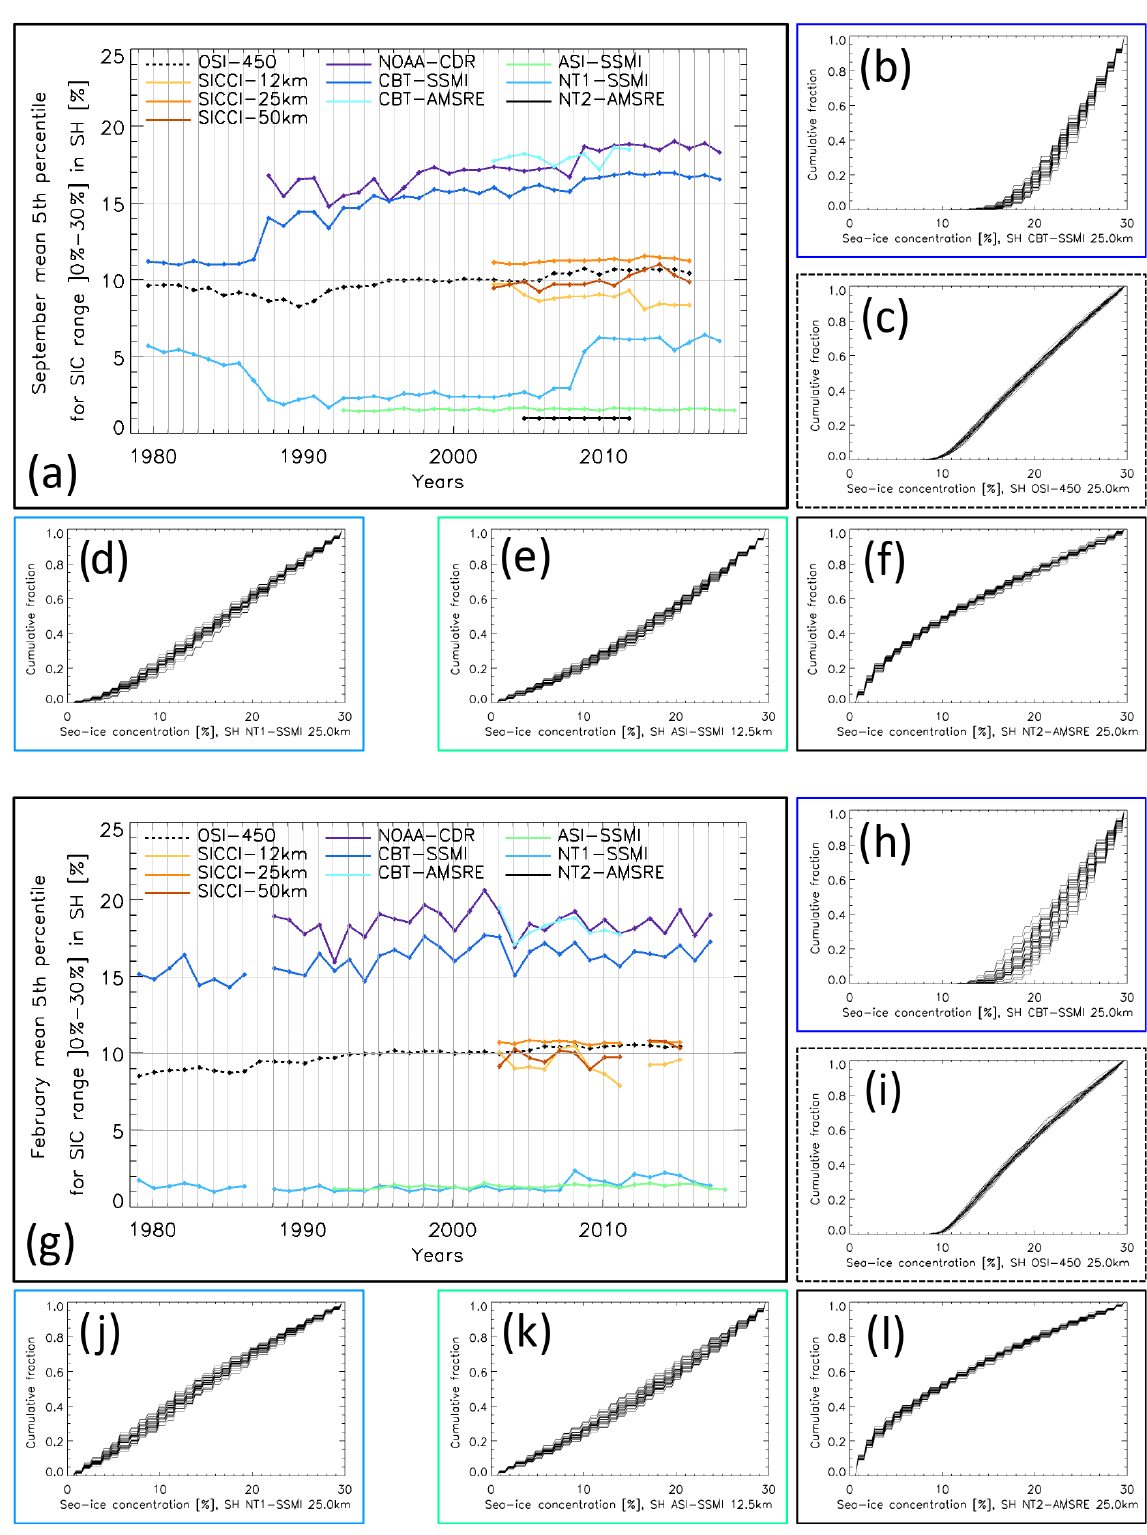
Figure 2. Time series of the monthly mean 5th percentile sea-ice concentration of the range ]0.0% to 30.0%] for the Antarctic in (a) Septem- ber and (g) February for all 10 products. Panels (b–f) and (h–l) show daily cumulative sea-ice concentration distributions of five selected products in these two months, respectively, in a sample year: 2004. See Table 2 for the time periods with data from the respective